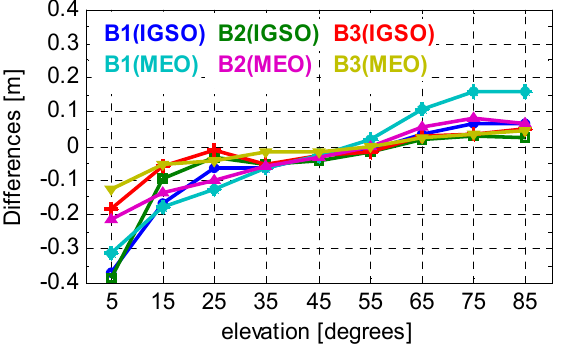
Figure 8. Differences of the code bias correction values compared with those of Wanninger and Beer.